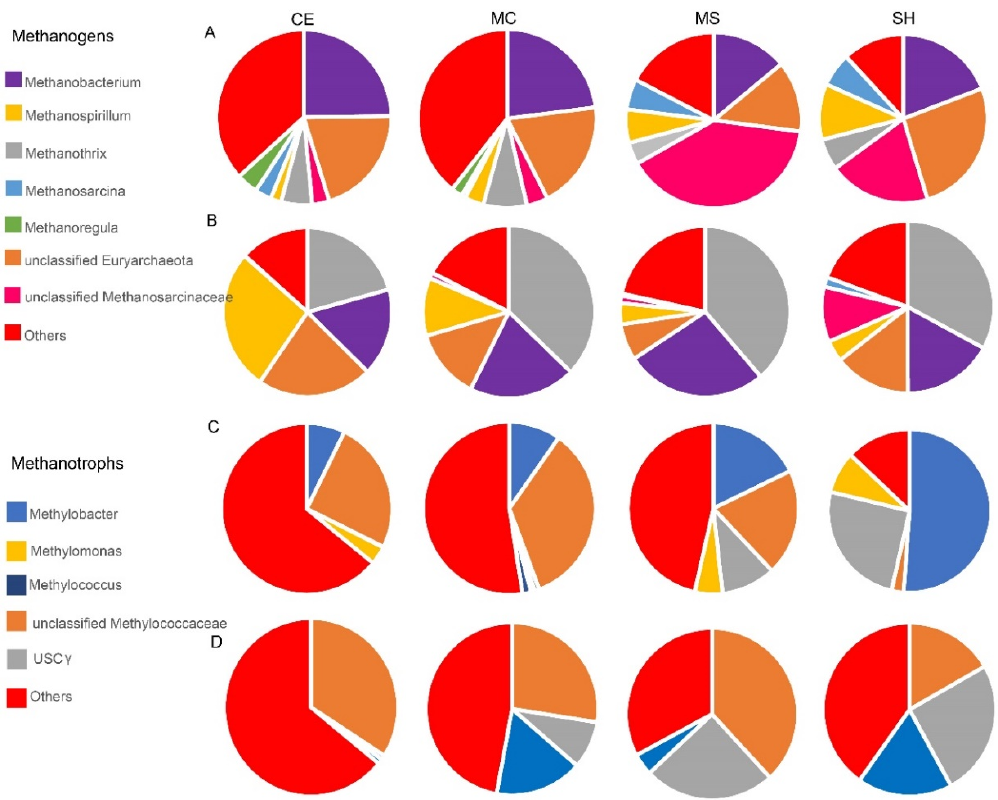
Figure 5. Microorganisms involved in methane cycling. ( A ) Methanogens in sediment at the genus level; ( B ) Methanogens in water at the genus level; ( C ) Methanotrophs in sediment at the genus level; ( D ) Methanotrophs in water at the genus level. Four sampling points: SH, MS, MC, and CE. Methane concentrations varied with layers and was different among points (Table